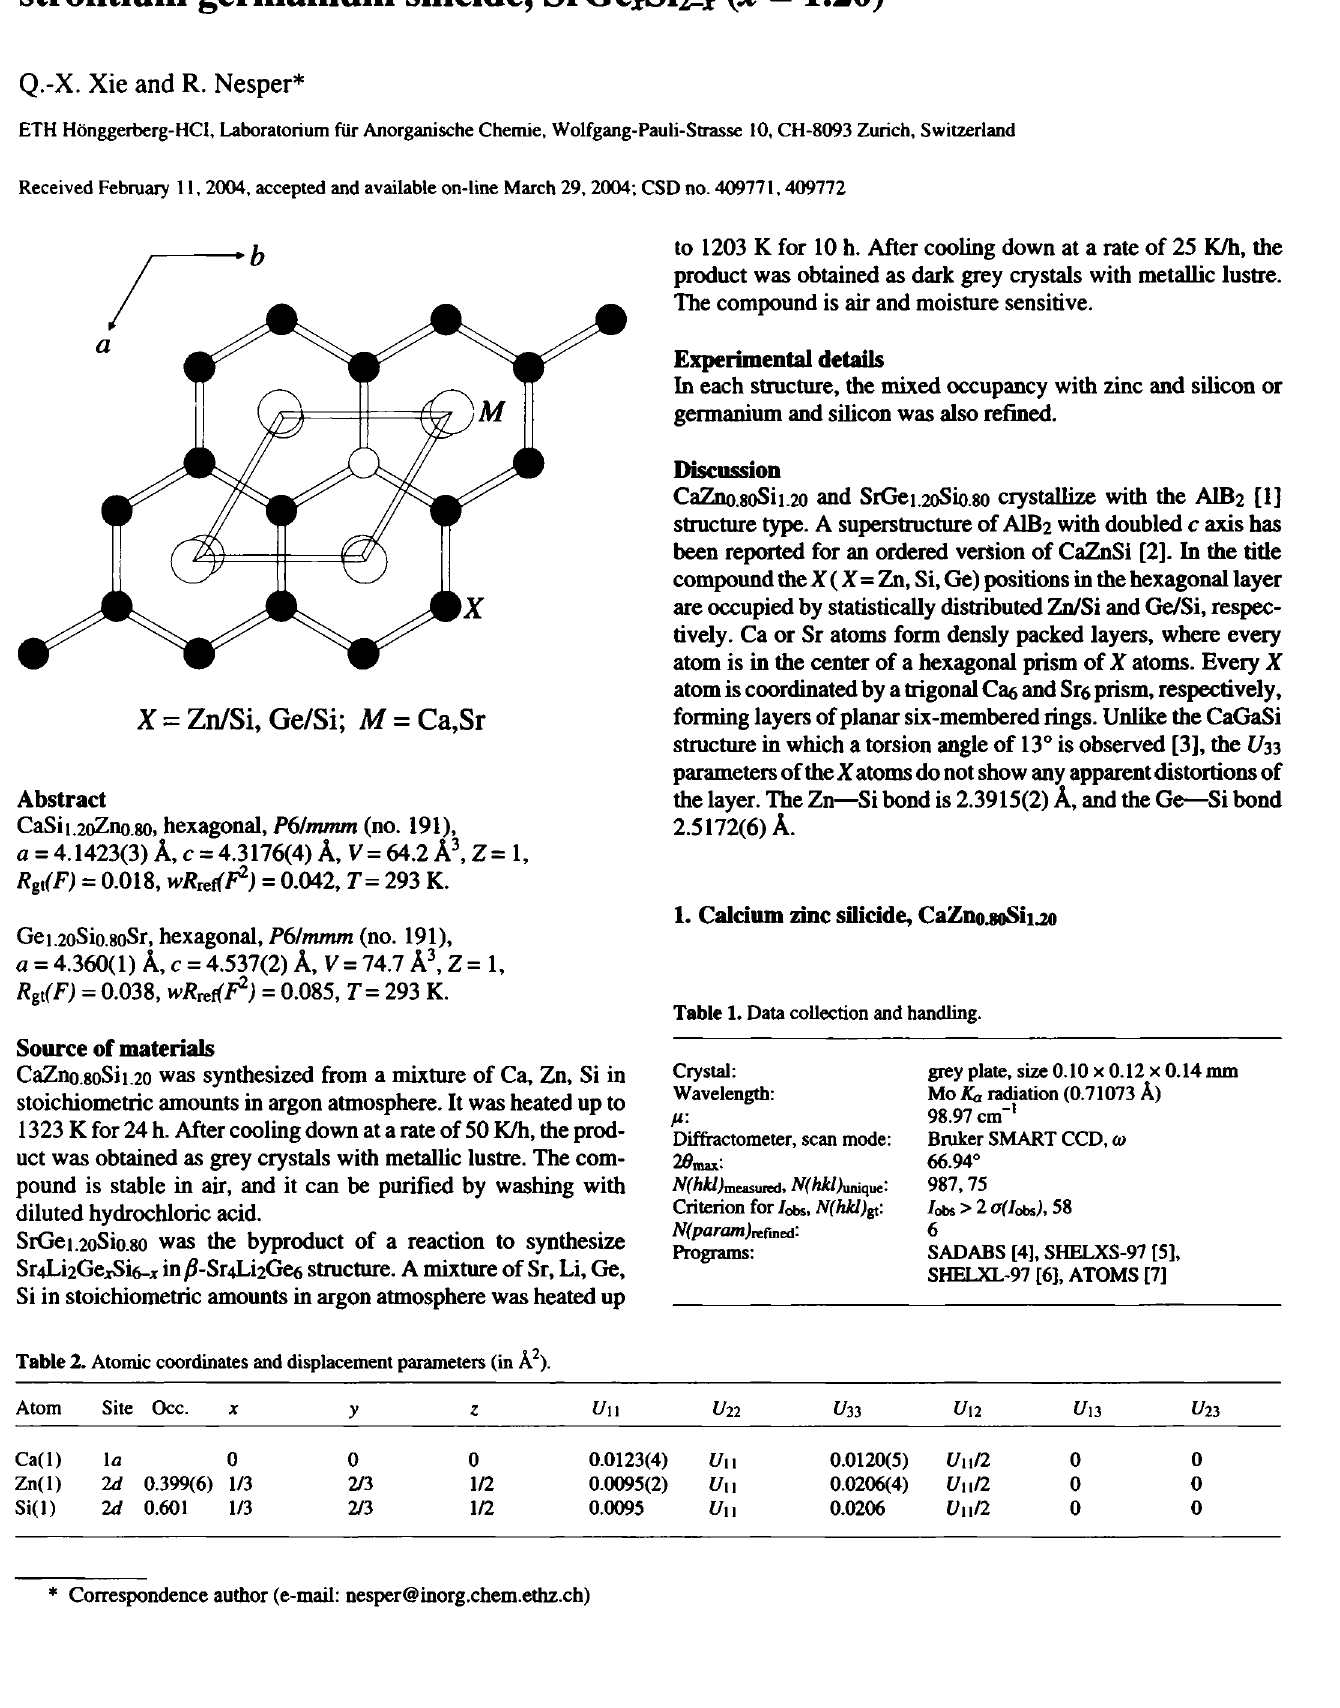
Table 2. Atomic coordinates and displacement parameters (in Ä 2